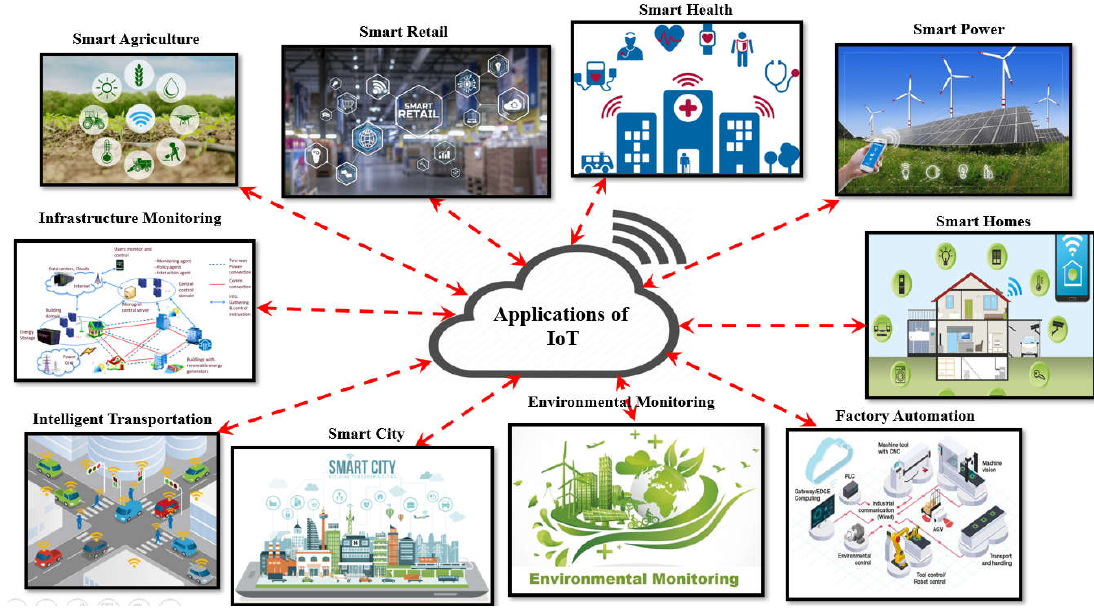
Figure 6. IoT in the real world.